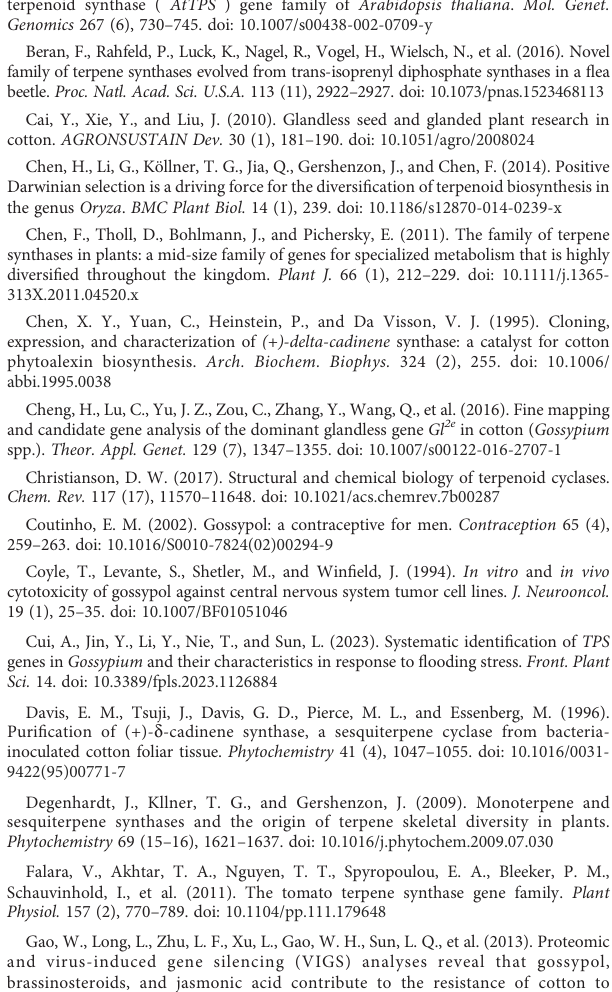
Bars represent SDs (standard deviation) of three independent biological replicates. The single asterisk indicates statistical signi fi cance at P < 0.05. The double asterisk indicates statistical signi fi cance at P < 0.01. SUPPLEMENTARY FIGURE 7 Multiple sequence alignment of GhCDN-A gene. DNAMAN8 was used to analyse the multiple sequence alignment of GhCDN-A gene. The conserved motif was marked by the black box, the sequence used for VIGS experiment was marked with red box. SUPPLEMENTARY FIGURE 8 Gene pro fi les in glandular and glandless materials. (A) Pearson correlation between the glandular and glandless plants. (B) Volcano plot showed the overlap of differentially expressed genes, FDR ≤ 0.01 and log 2 |FC| ≥ 1. (C) The KEGG classi fi cation of up-regulated genes. (D) The KEGG classi fi cation of down-regulated genes. SUPPLEMENTARY FIGURE 9 The relative expression of key gene. (A) The relative expression of TIFY9 gene in gossypol and gossypol-free materials. (B) The relative expression of GhCDNA gene in gossypol and gossypol-free materials. (C) The relative expression of GhCDNA in GhJAZ1 overexpressed gene